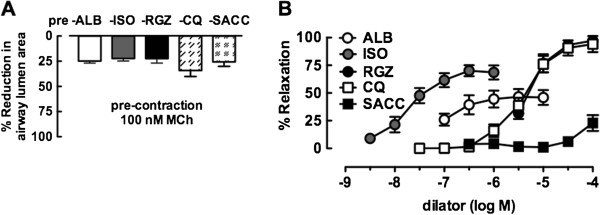
Rosiglitazone and chloroquine, but not isoproterenol, albuterol or saccharin, elicit full relaxation of mouse small airways in lung slices. Airways were A) pre-contracted with 100 nM methacholine (MCh) to achieve ~25% reduction in lumen area over 5 min prior to B) cumulative additions of albuterol (ALB, n = 9), isoproterenol (ISO, n = 7), rosiglitazone (RGZ, n = 4), chloroquine (CQ, n = 6) or saccharin (SACC, n = 4) at 5 min intervals. Responses (mean ± S.E.M) represent A) the reduction in lumen area to MCh and B) the% relaxation of this pre-contraction averaged over the last minute of each perfusion.